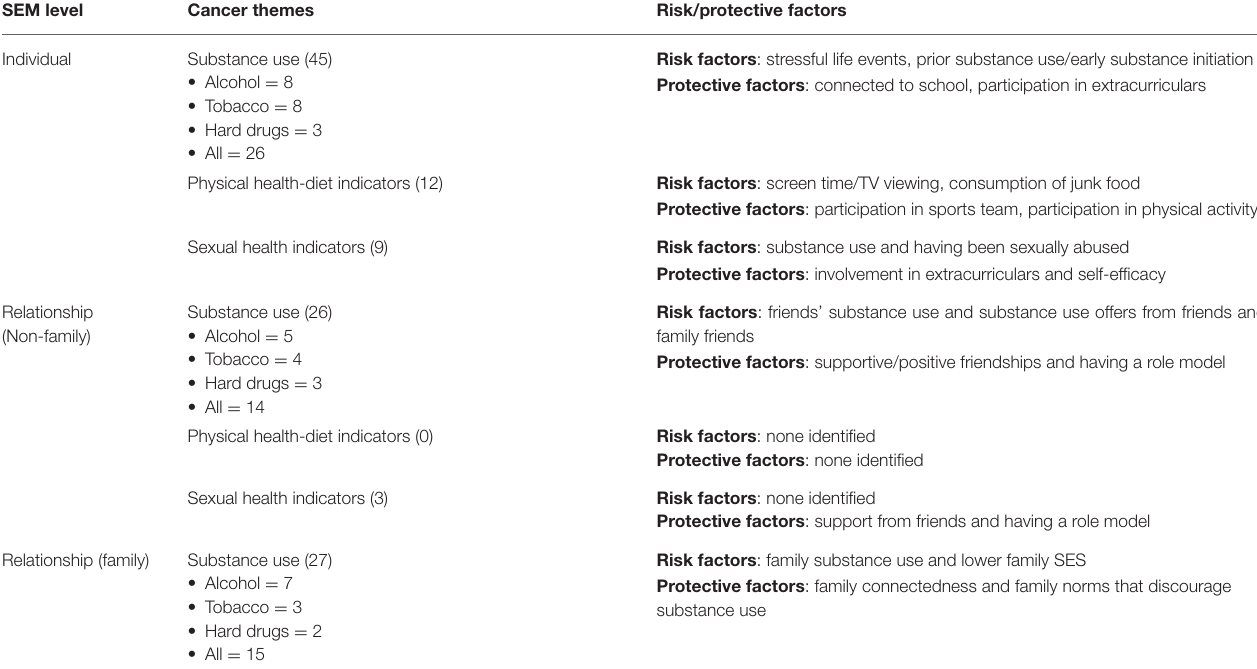
TABLE 1 | Risk and protective factor themes.